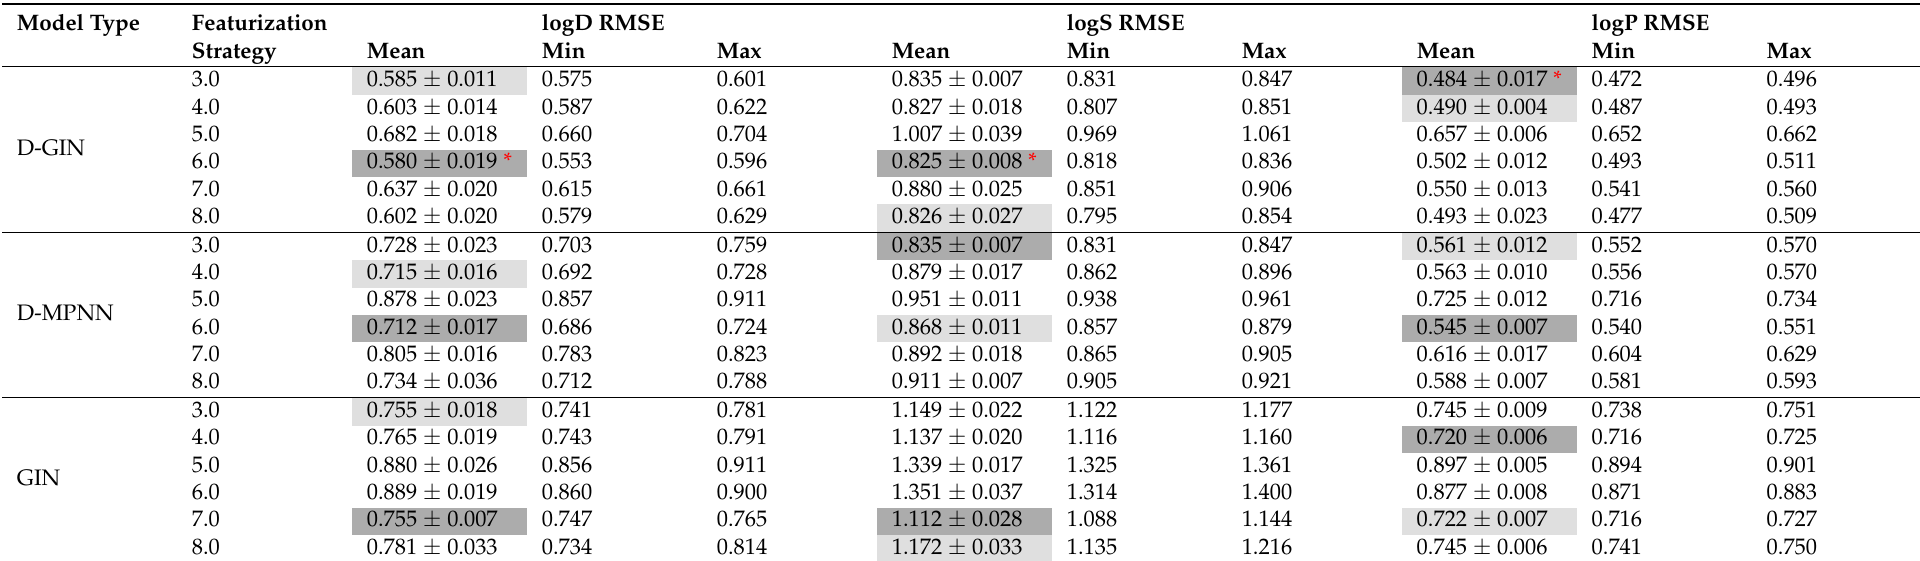
Table 4. Impact of the featurization on the different molecular properties. For each property and model type, the mean, minimum, and maximum RMSE are shown. The dark gray boxes represent the best RMSE for the particular property and model type, the light gray the second best. The red asterisk is the overall best RMSE for the particular